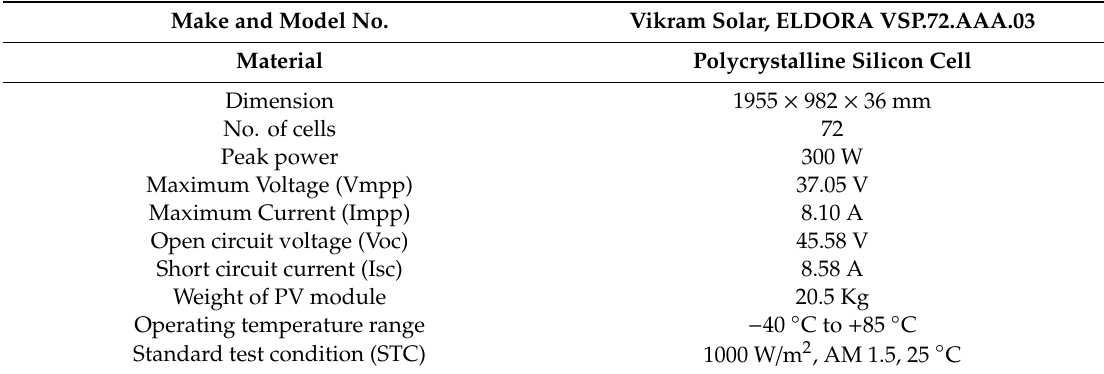
Table 3. Specification of PV panel.